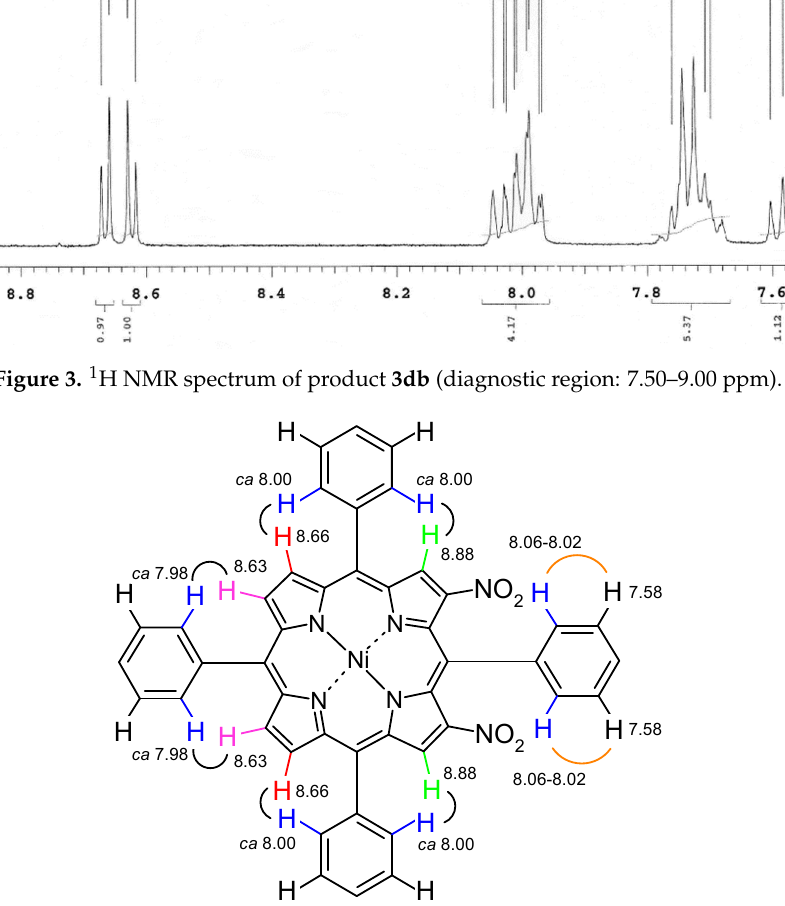
Figure 4. The diagnostic 2D correlations observed for product 3db : COSY correlations—orange arches; NOESY correlations—black arches.